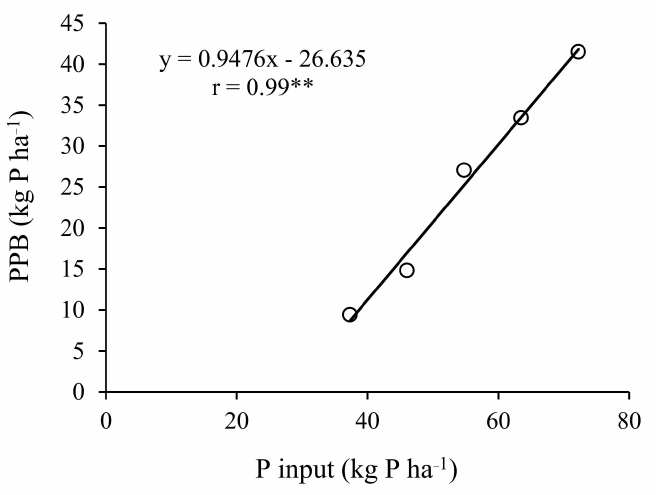
Figure 5. The correlation between total P input with partial P balance (PPB) of fertilization treatments. **, significant at p < 0.01.